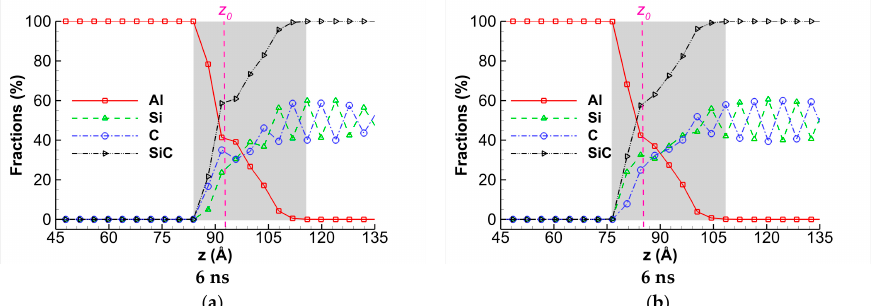
Figure 3. The concentration profiles of Al, Si, and C atoms along the z -direction during interdiffusion of the C-terminated ( a ) 6H-SiC/Al and ( b ) 3C-SiC/Al interfaces with 20% vacancy in SiC. The concentration profiles of atoms at 300 K before relaxation and after maintaining the systems at 1000 K for 0, 2, 4, and 6 ns are illustrated. The grey zone in the figures indicates the diffusion zone and its thickness measured in Å.